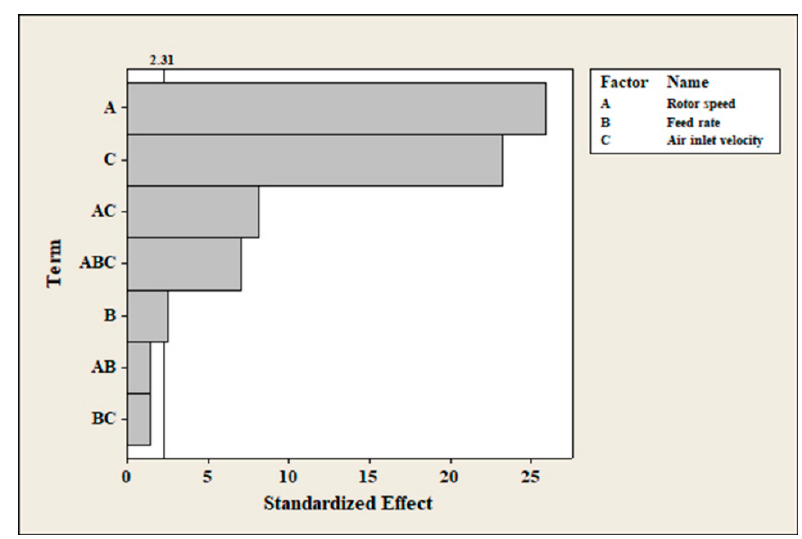
Figure 5. Pareto chart of standardized effects for cut size ( α = 0.05).